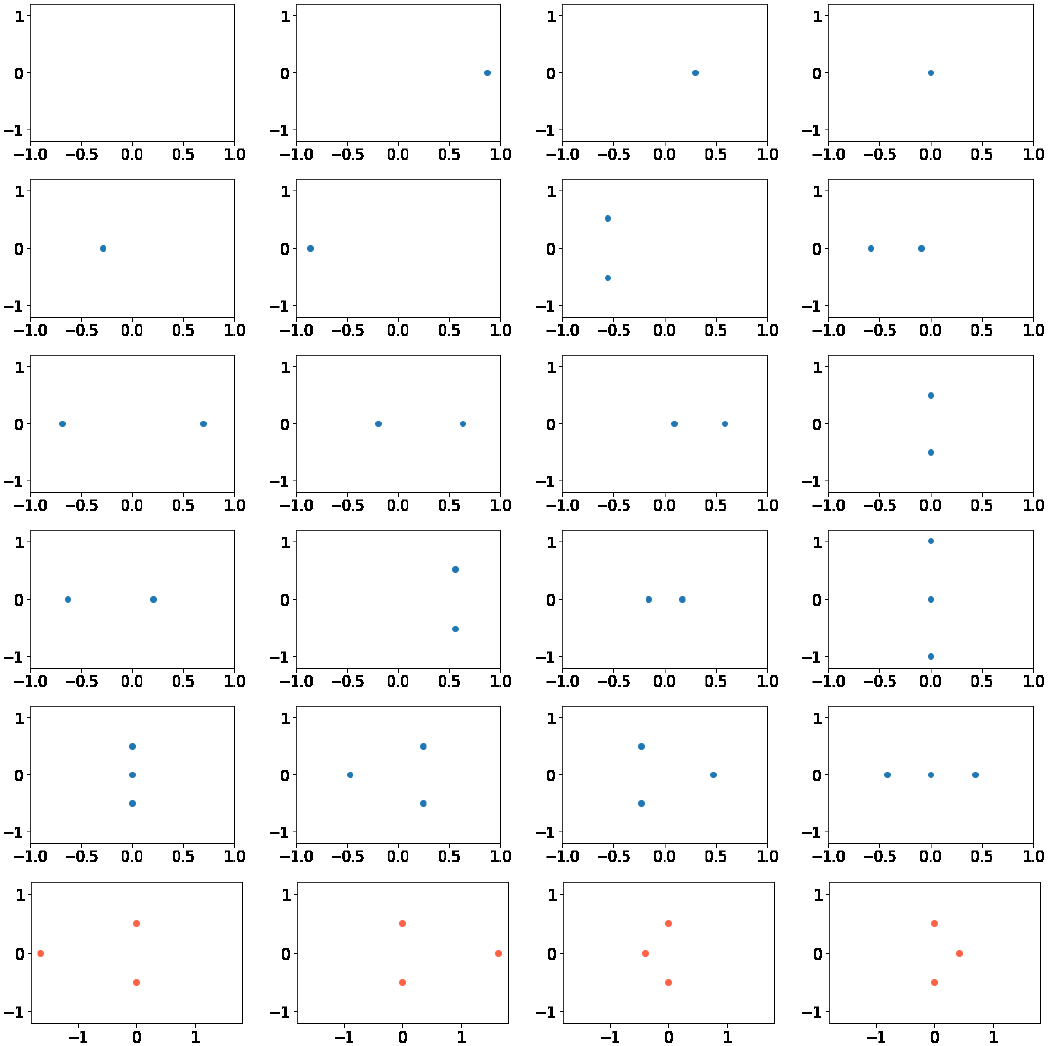
Figure 1 . In blue: the roots of all the solutions Q ( (cid:21) ) to the two TQ relations (4.1) in size L = 6. In red: the roots of the solutions to the (cid:12)rst TQ relation in (4.1) that are not solution to the second one, and thus that do not contribute to the